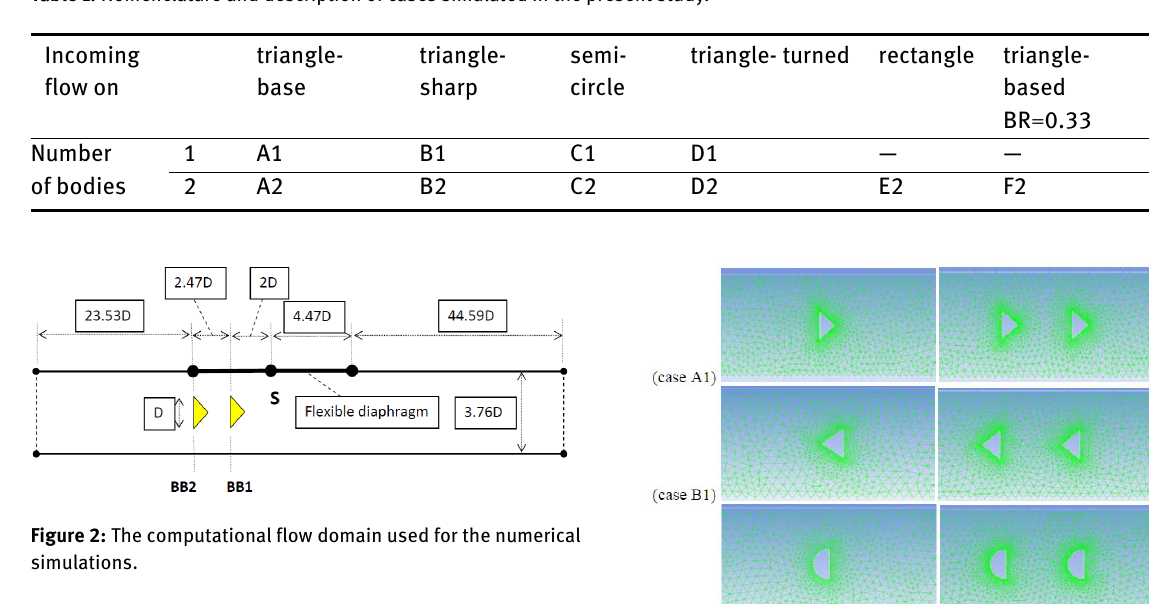
Table 1: Nomenclature and description of cases simulated in the present study.